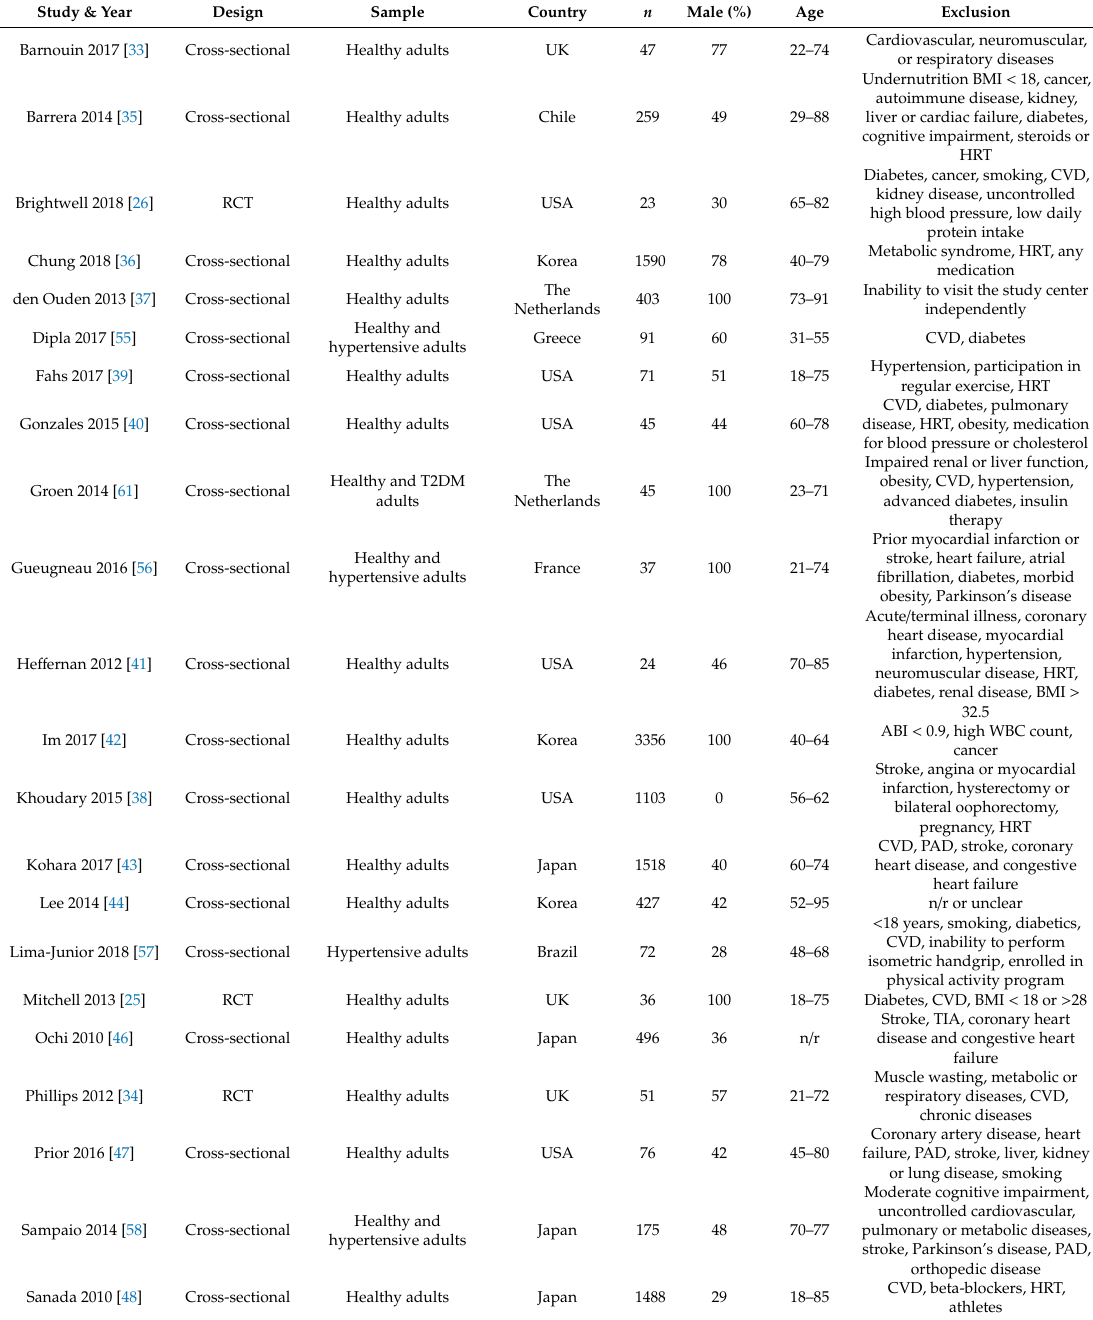
Table 1. Study details and sample